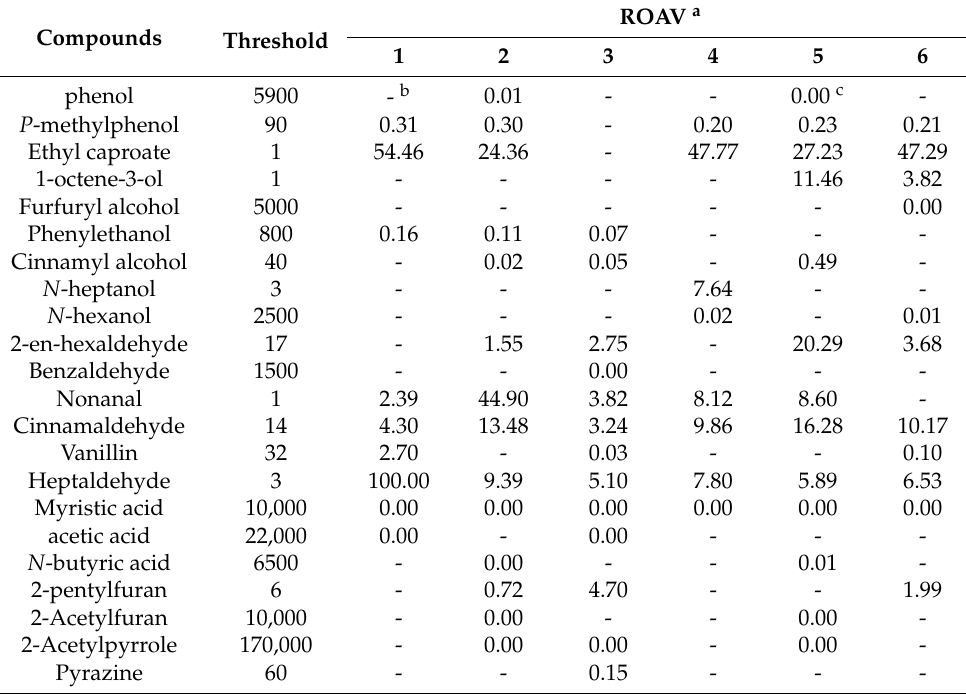
Table 3. ROAV analysis of Bletilla striata